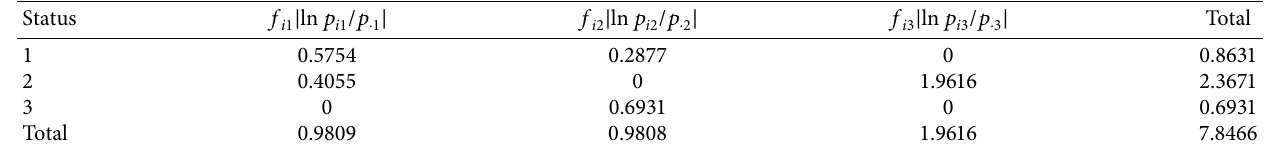
Table 4: Statistical calculation table.